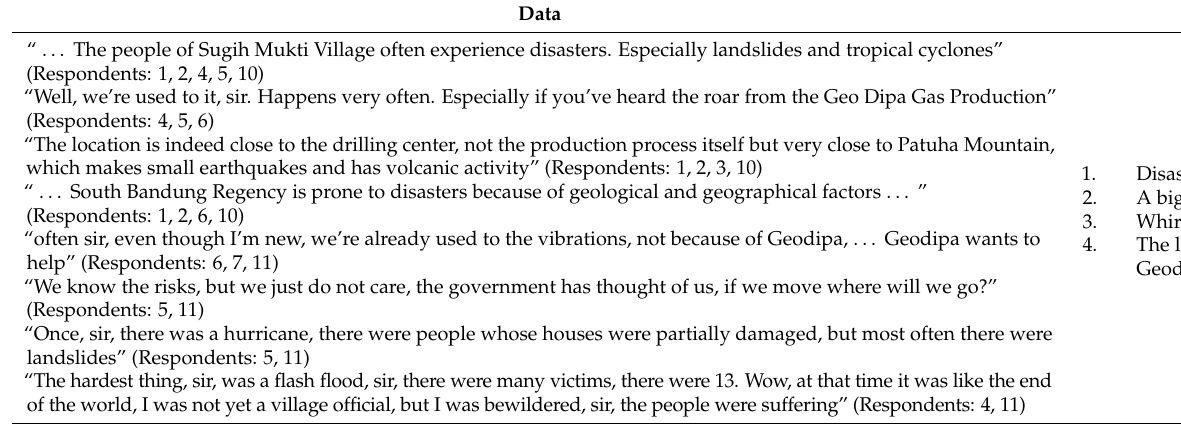
Table 1. Qualitative data of the FGD